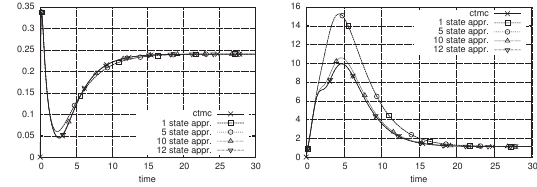
Figure 7: Probability of having one customer and variance of the number of customers at the second station as function of time starting with 10 customers at station 1 with λ = 1 ,μ 1 = 5 ,μ 2 = 2 . 5 .